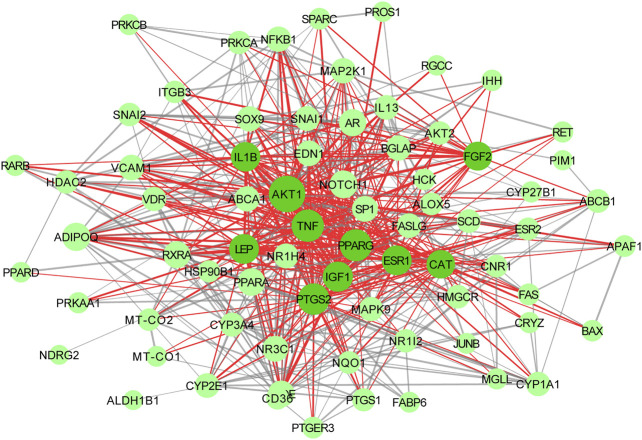
Interactive PPI network of WCAF and colorectal cancer. with 71 nodes and 551 edges: nodes indicate target proteins or genes; edges represent correlations between targets; the size of the nodes indicates the value of degree.